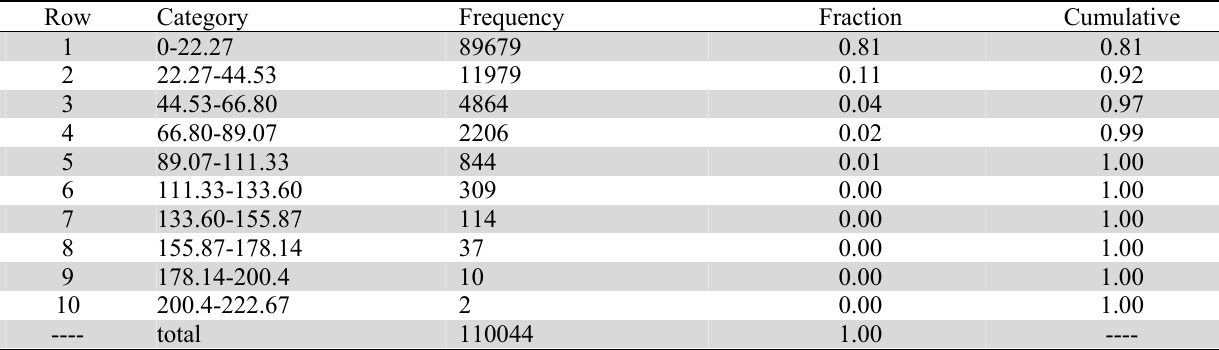
Daily cash withdraw ATMs